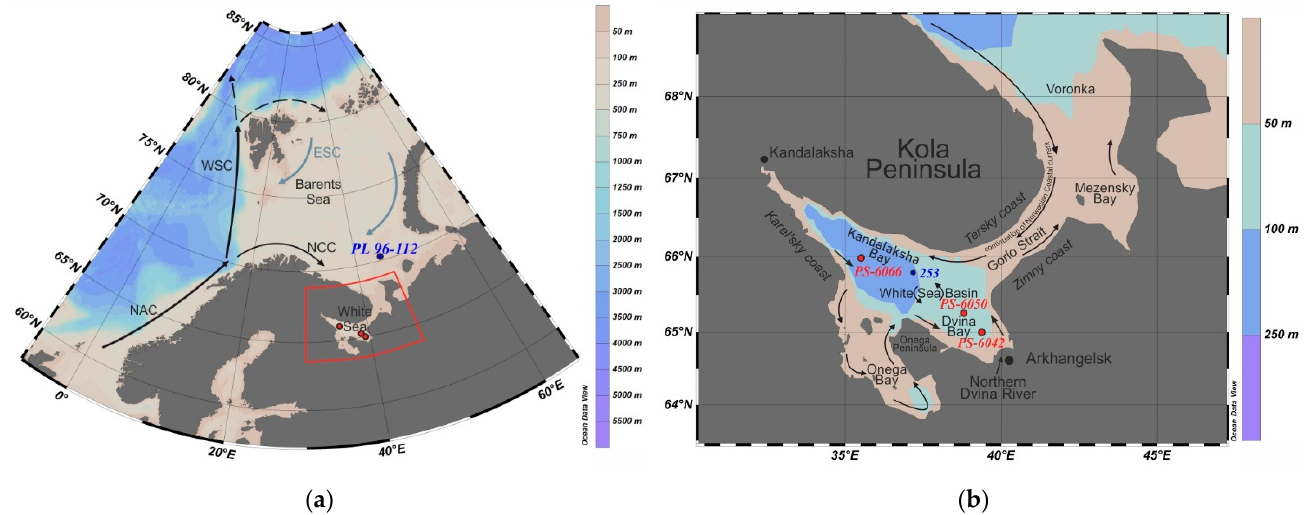
Figure 1. Map showing the locations of the studied cores and modern surface currents in the North Atlantic ( a ) and the White Sea ( b ). Arrows indicate the direction of surface currents: ESC—East Spitsbergen Current; WSC—West Spitsbergen Current; NAC—North Atlantic Current; NCC—Norwegian Coastal Current. Sediment core sites from this and previous studies are indicated by red and blue circles, respectively: Core 253 [20], PS ‐ 6050, PS ‐ 6042 by [21,22], and PL 96 ‐ 112 by [23].